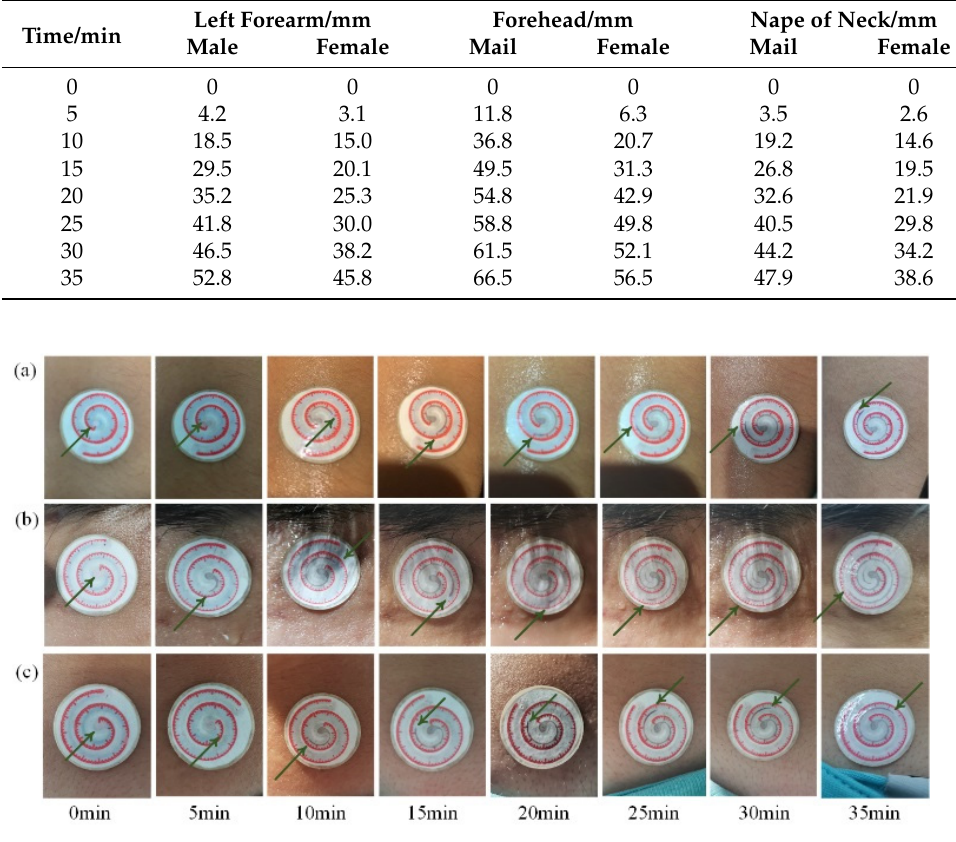
Figure 11. Photographs of P-SRMC changing color on the ( a ) left forearm, ( b ) forehead, and ( c ) nape of the neck taken every 5 min while the volunteers was running on a treadmill.